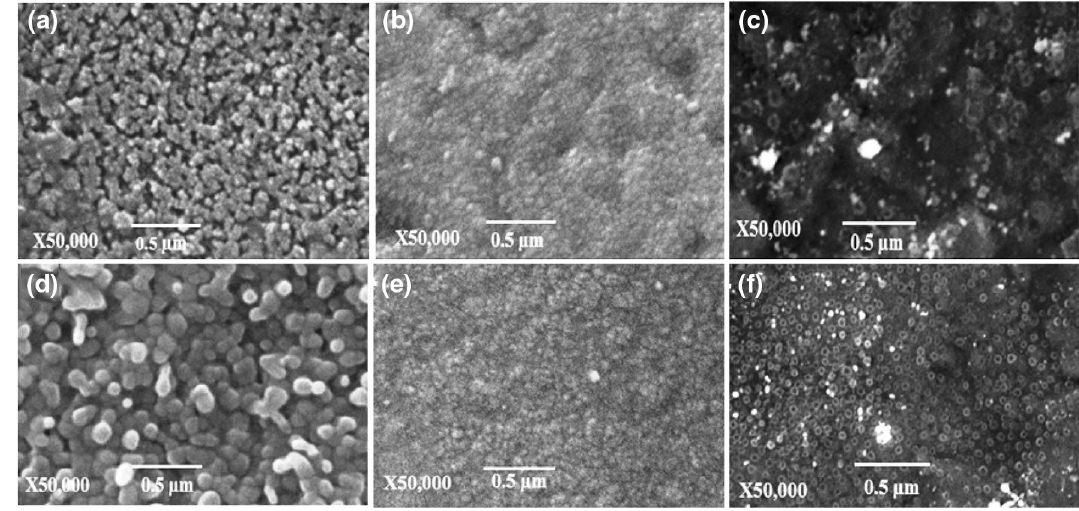
Fig. 6 SEM images of ZnO ( a ) CuO ( b ) and bilayer films ( c ) at 400 °C and ( d–f ) at 500 °C,